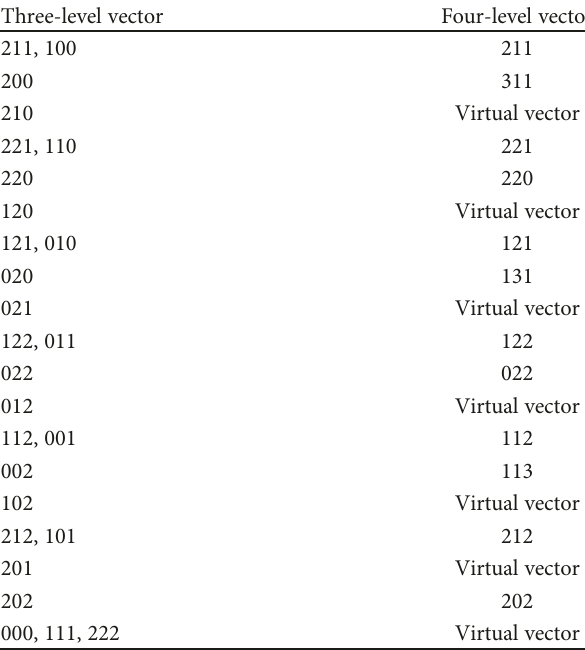
Table 3: Relationship between three-level inverter voltage vector and four-level inverter voltage vector.